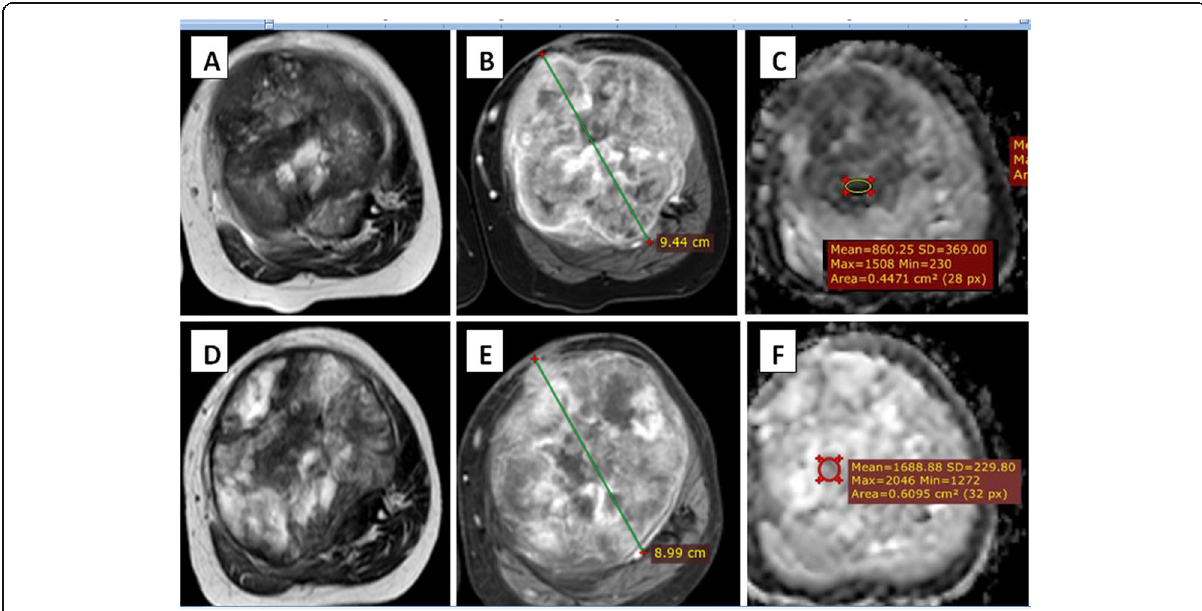
Fig. 2 A 22-year-old male with osteosarcoma in the left proximal tibia. MR images a – c before and d – f after chemotherapy. a , b Axial T2-WI and contrast-enhanced T1-WI showing left upper tibial intra medullary infiltrative lesion associated with extra osseous soft tissue component. It elicits high T2 signal and heterogeneous post contrast enhancement with areas of necrosis and cystic degeneration. c ADC map revealed patchy diffusion restriction of the lesion with mean ADC value (mean, 0.86 × 10 − 3 mm 2 /s). d , e Follow-up axial T2-WI and contrast-enhanced T1-WI showing slight size regression with less contrast uptake. f Follow-up ADC map showing elevated ADC values (mean, 1.68 × 10 − 3 mm 2 /s) denoting